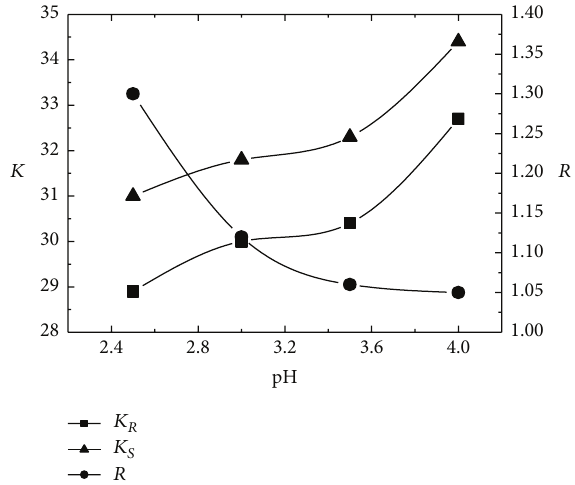
Figure 3: Effect of the pH of aqueous buffer. Mobile phase: aque- ous buffer/methanol/acetonitrile of 21 :3 :1 (v/v/v); 5mM sodium dihydrogen phosphate, 12mM SBE- 𝛽 -CD, flow rate of 1.0mL/min, detection wavelength of 240 nm, and temperature of 25 ∘ C. 𝐾 𝑅 and 𝐾 𝑆 , retention factors of ( 𝑅 )-CIT and ( 𝑆 )-CIT, respectively; 𝑅 ,